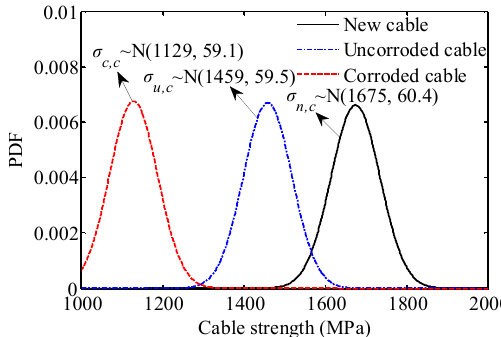
Figure 2. Comparison of the normalized PDFs of wire strength accounting for cable corrosion.